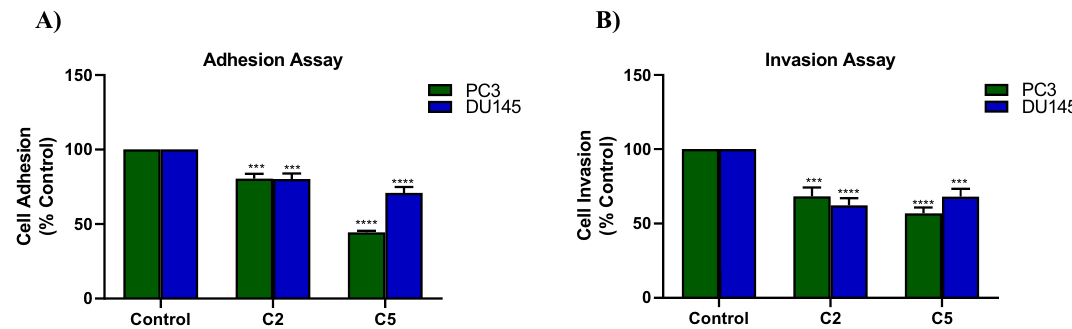
Figure 4. Effects of compounds C2 and C5 on PC3 (Green) and DU145 (Blue) cells adhesion ( A ) and invasion ( B ). Data in A and B are shown as mean ± SD of triplicates compared with the untreated control. One-way ANOVA analysis using Tukey’s post hoc test was used to indicate significance. *** P -value ≤ 0.001, **** P -value ≤ 0.0001 compared to